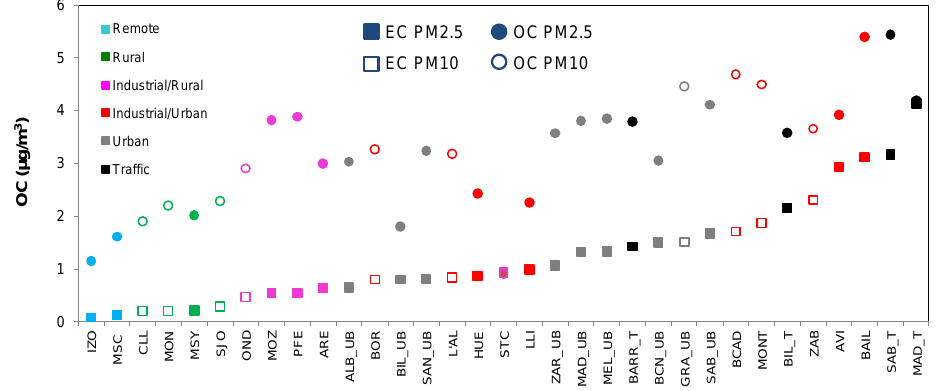
Figure 4. Mean EC and OC levels in PM2.5 (solid) and PM10 (blank) recorded in the 33 study sites ordered from low to high EC levels and classified according to the site type.